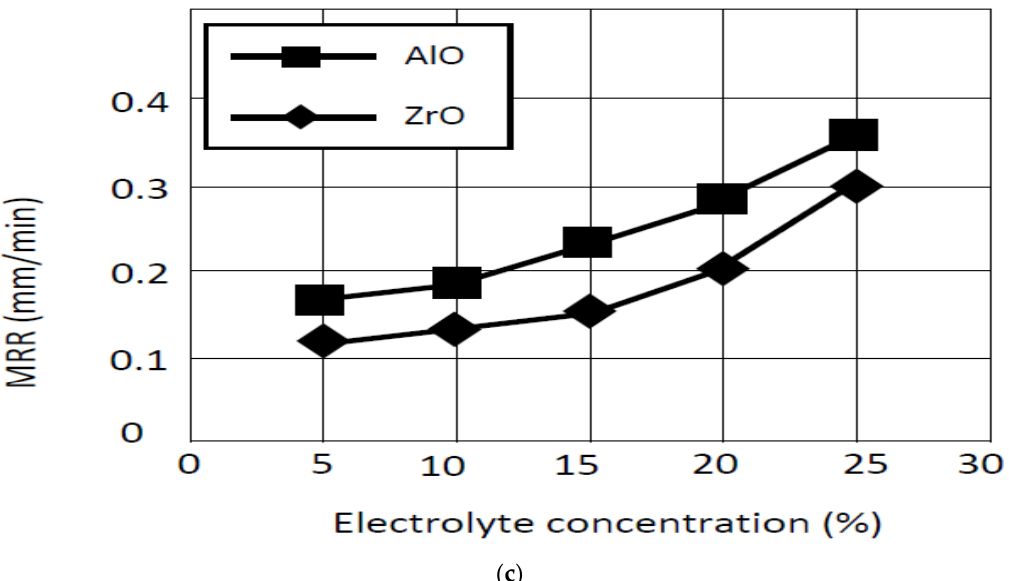
Figure 22. ( a ) Principle of gas-filled electro discharge and electrochemical compound machining (GFEECM), ( b ) Effect of peak current, ( c ) Effect of pulse duration on the MRR. (Reproduced with permission from [159]).